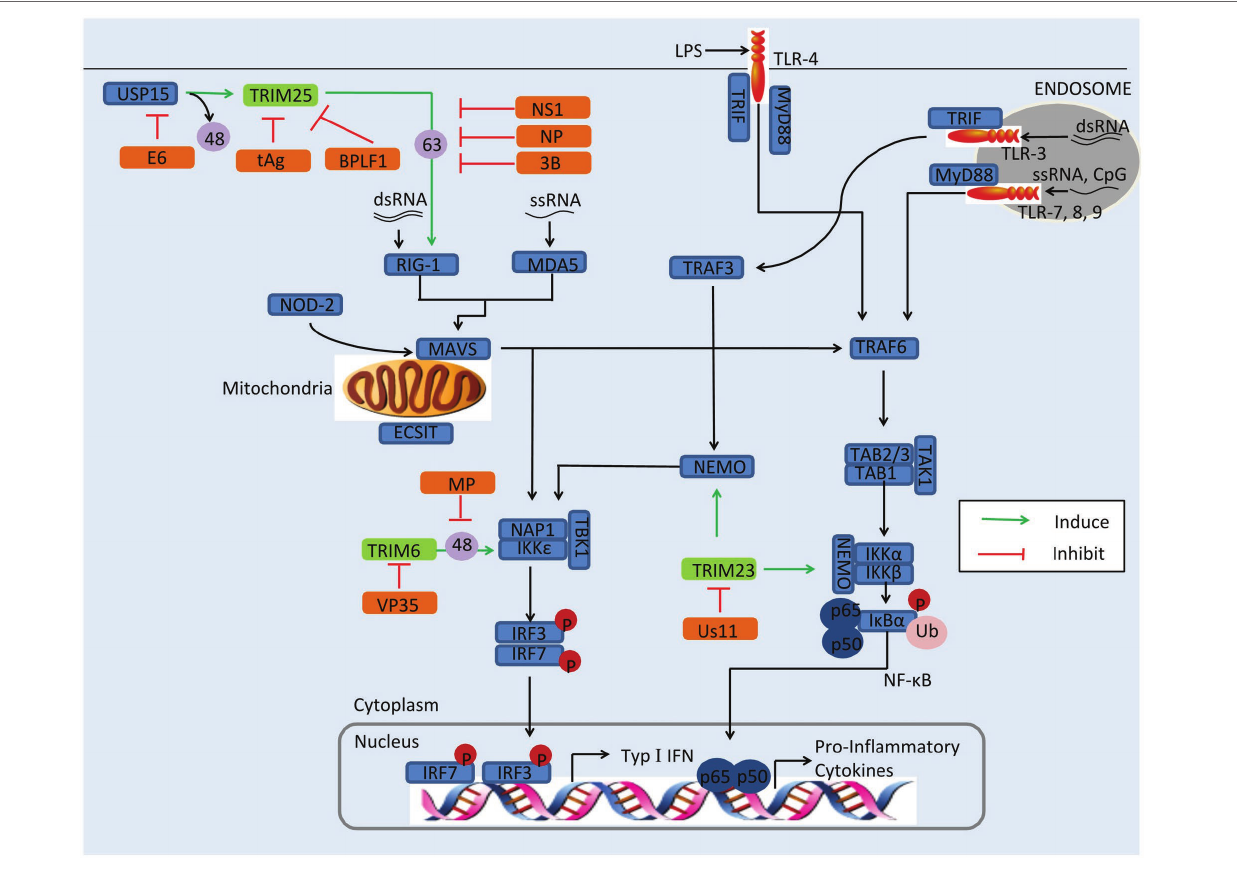
FIGURE 2 | Viral evasion of immunity via antagonization of TRIMs. Some TRIMs (green) positively regulate innate immune response. Viral proteins (orange) antagonize these TRIMs to reduce the production of type I IFNs and inflammatory factors. BPLF1, the deconjugases of HSV; E6, the oncoprotein of HPV16; MP, the matrix structural protein of NiV; NS1, the nonstructural protein 1 of IAV; NSs, the nonstructural protein NSs of SFTSV; NP, the nucleocapsid protein of SARS-CoV, MERS-CoV, or SARS-CoV-2; tAg, the small t antigen of JCV; Us11, the Us11 protein of HSV-1; VP35, the VP35 protein of EBOV; 3B, the 3B protein of FMDV; 48, K48-linked polyubiquitination; and 63, K63-linked